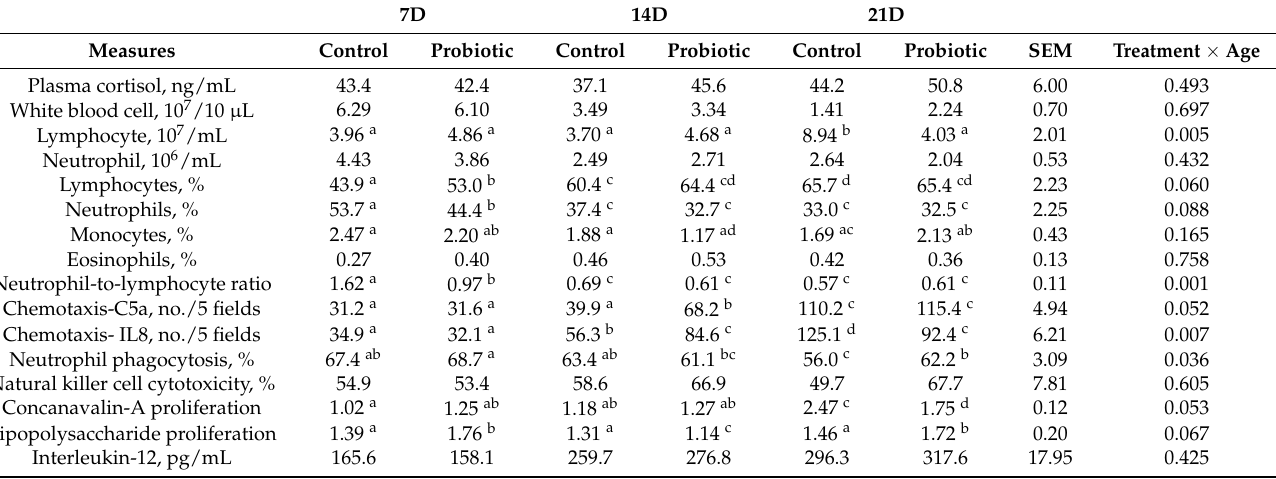
Table 3. Interactive effects of maternal treatment on the progeny’s mean plasma cortisol and descrip- tive and functional immune measures during the suckling phase at 7, 14, and 21 days of age (before weaning) 1,2